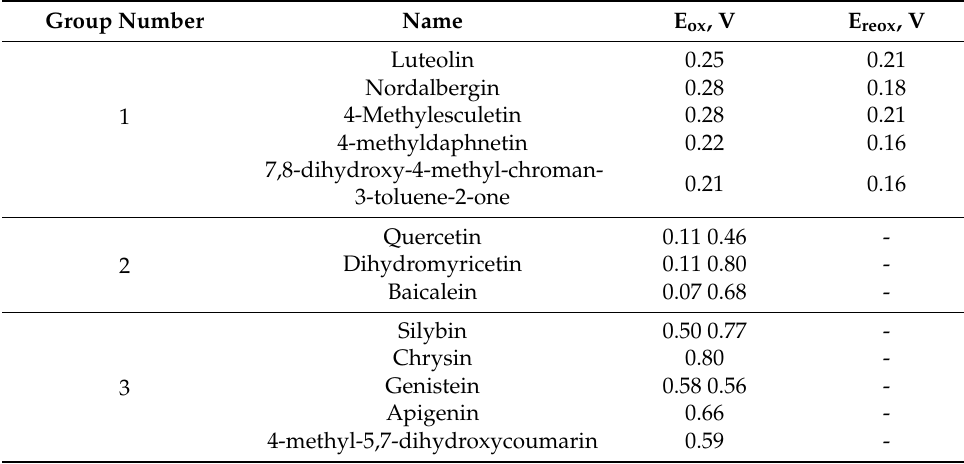
Table 2. Potentials of antioxidant oxidation peaks. Group